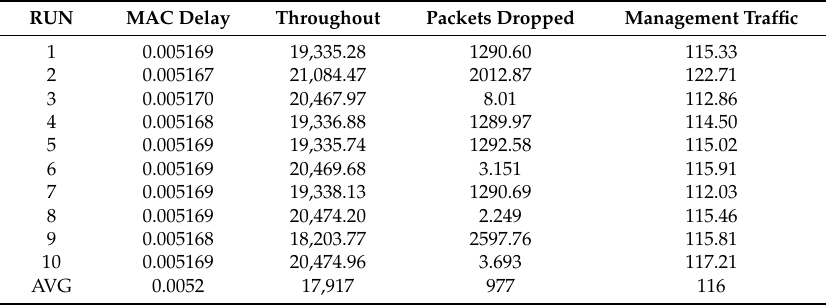
Table 15. Patient Bed Scenario